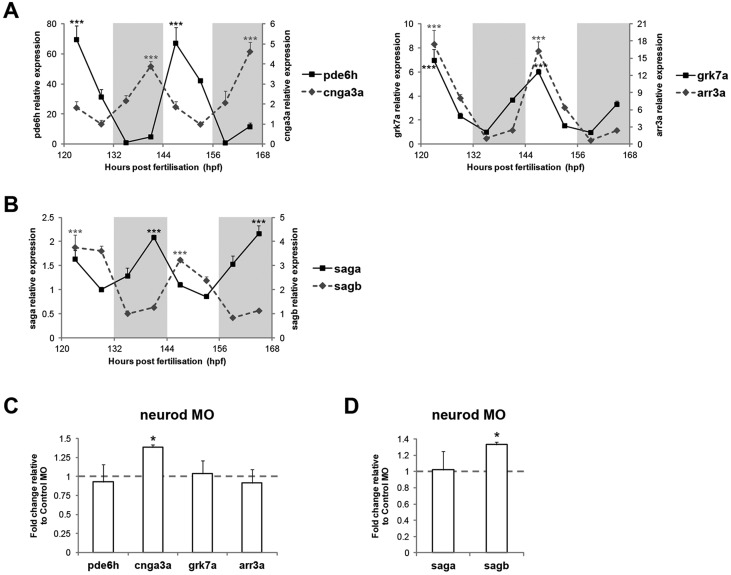
Regulation of phototransduction gene expression during zebrafish development. (A,B) qPCR analysis of cone-specific (A) and rod-specific (B) phototransduction genes on 6-7 dpf larvae raised on an LD cycle (n=3). White and grey backgrounds represent light and dark phases, respectively. Statistically significant differences between the expression peak and trough on each day (Fisher's LSD test) are indicated: ***P<0.001. (C,D) qPCR analysis of cone-specific (C) and rod-specific (D) phototransduction genes on 6 dpf larval eyes injected with neurod vivo-morpholino or control vivo-morpholino (n=3). Larval eyes were collected at ZT3 (C) or ZT15 (D). *P<0.05 (Student's t-test). Error bars indicate s.e.m.